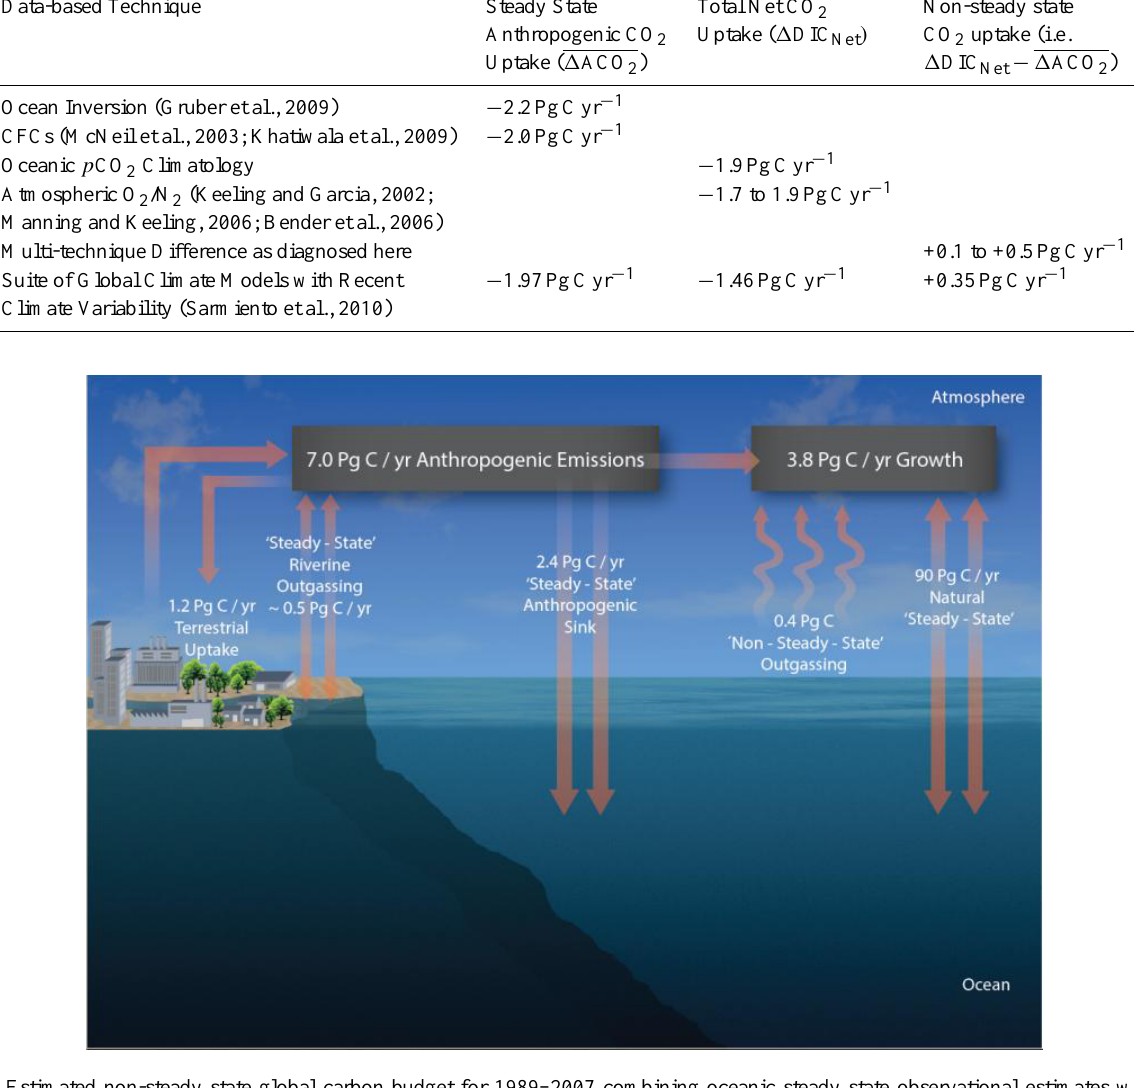
Fig. 2. Estimated non-steady state global carbon budget for 1989–2007 combining oceanic steady state observational estimates with the oceanic non-steady state signal as diagnosed from data and models in this